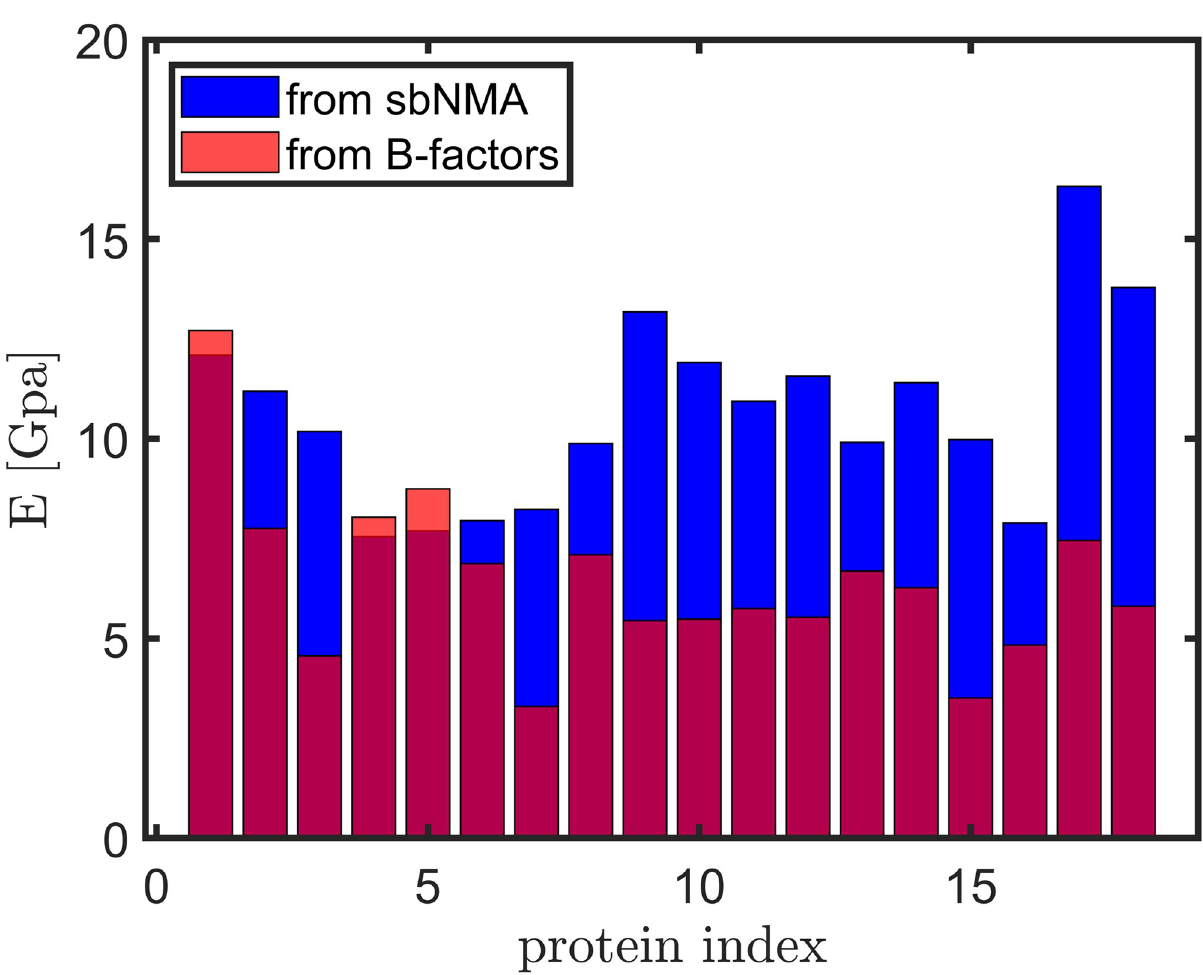
Fig 6. A bar plot of the Young’s moduli ( E ) calibrated with sbNMA (in blue) and those with crystallographic B-factors (in red), for the 18 proteins in the dataset (listed by their sizes in the ascending order). The blue bars can be interpreted also the Young’s moduli at temperatures below T the red bars Young’s moduli at the room